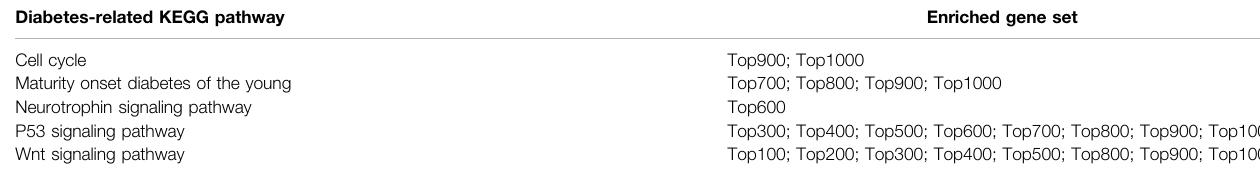
TABLE 3 | The diabetes-related KEGG pathway enrichment of top N gene sets calculated by SIMPO-TSS1500. Diabetes-related KEGG pathway